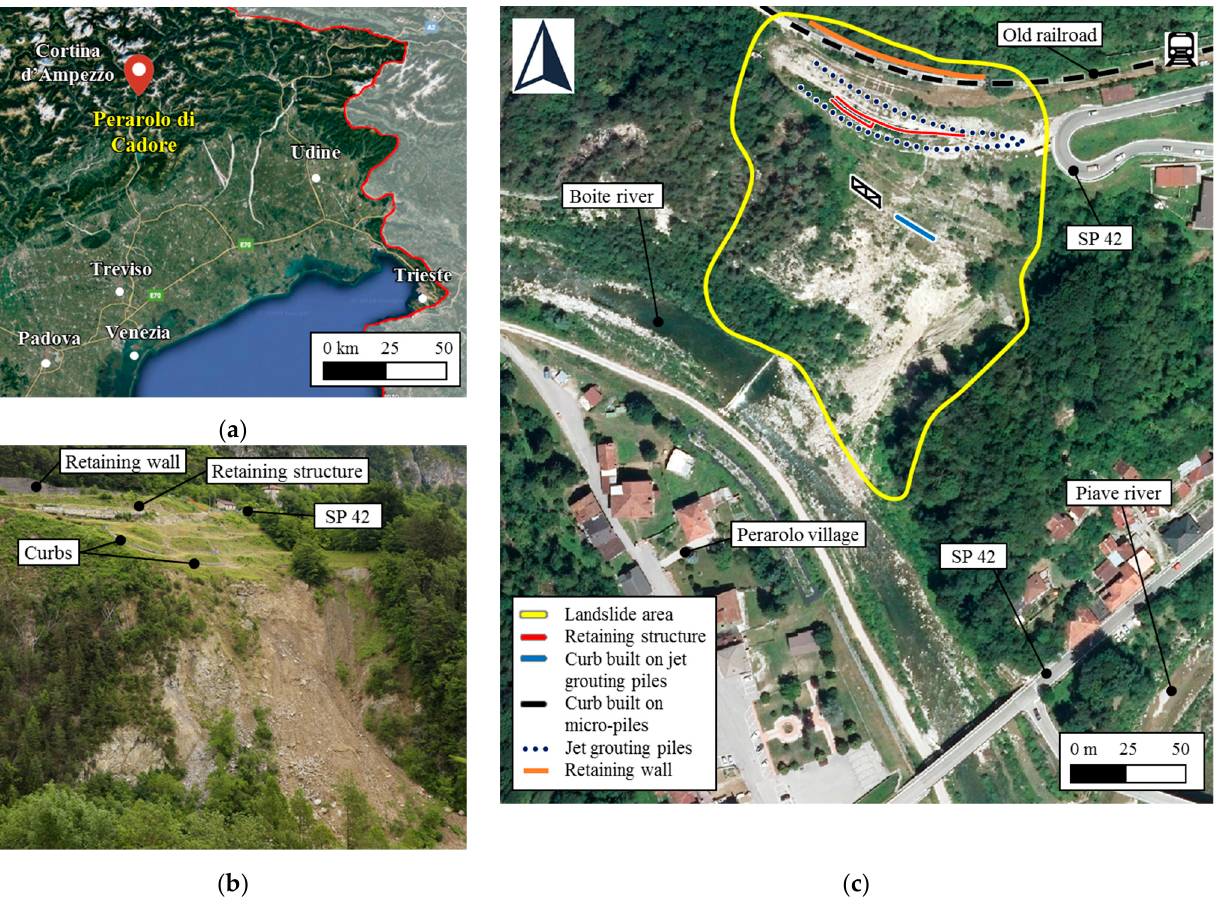
Figure 1. ( a ) Location of Perarolo di Cadore (NE Italy); ( b ) frontal view of the landslide area; ( c ) orthophoto of Sant’Andrea landslide site and its neighborhood. In the orthophoto the boundary of landslide as well as the rivers Boite and Piave, Perarolo village, the main human infrastructures existing near the landslides and the main reinforcement structures built in the past to stabilize the slope are indicated.